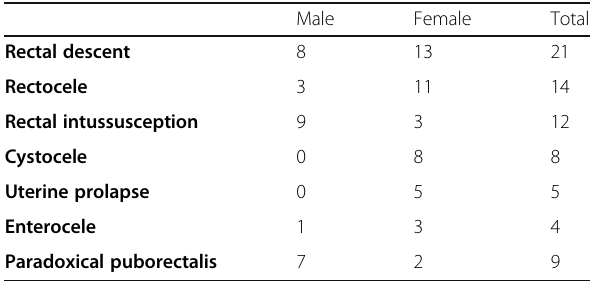
Table 3 Comparison between male and female MR